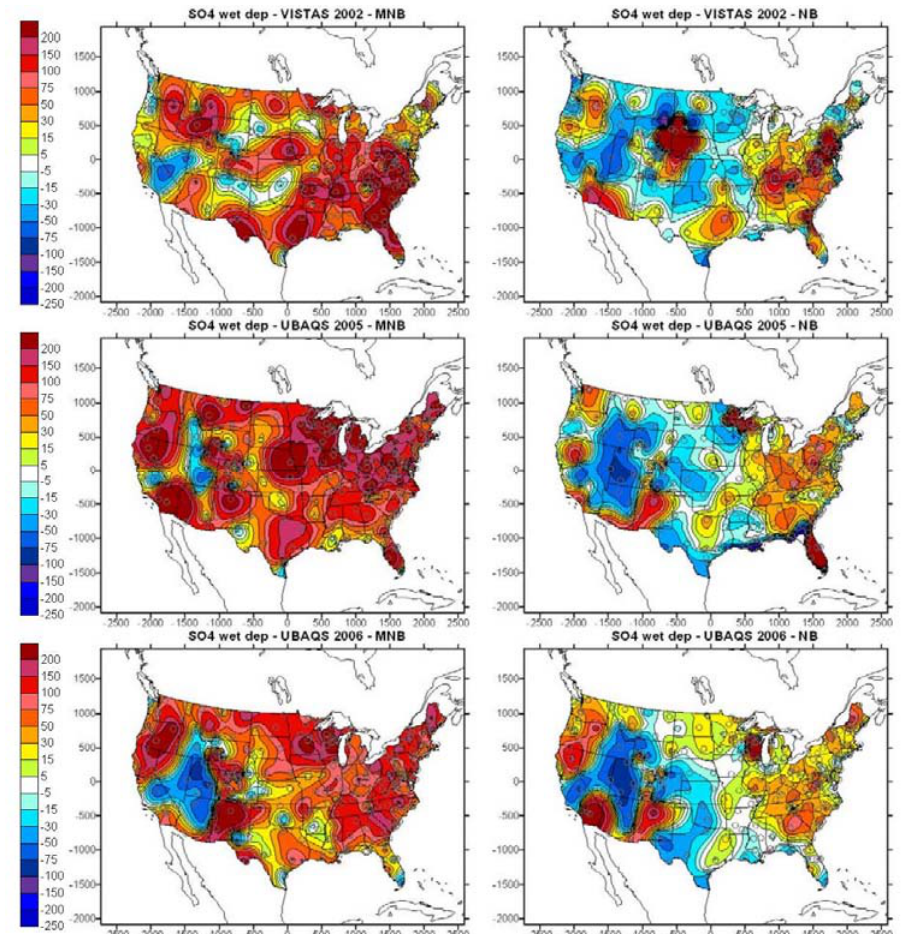
Figure 3. Spatial maps of mean normalized bias (MNB) for modeled SO using weekly total ( left ) and annual total ( right ) deposition values from the VISTAS 2002 ( top ) and UBAQS 2005 ( middle ) and 2006 ( bottom ) CMAQ simulations. Contours are created using Kriging interpolation of values at NADP stations (circle